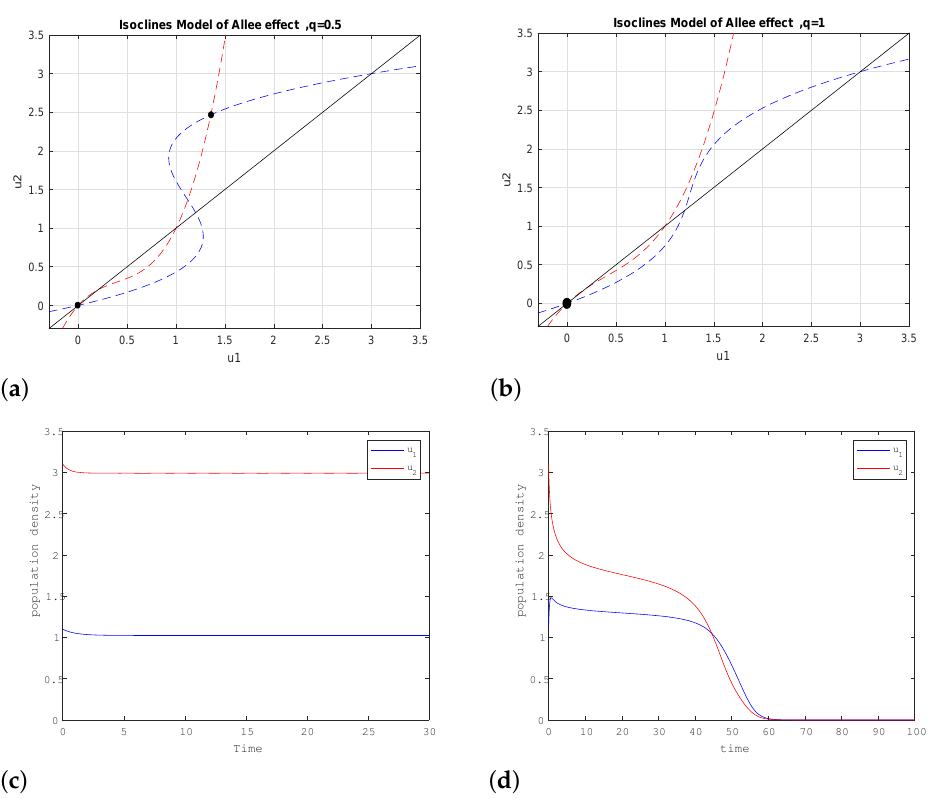
Figure 2. ( a , b ) The phase plane of system (4) shown for different values of the coupling strength: ( a ) q = 0.5 and ( b ) q = 1. The black dot shows the positive steady state, the black line is the bisector line. The positive steady state exists in ( a ) but disappears in ( b ). Other parameters are k 1 = 1, k 2 = 3, α 1,2 = 1, β 1 = 0.2 and β 2 = 1.2. ( c , d ) The temporal dynamics of the system obtained for cases ( a , b ), respectively, for the initial conditions u 1 ( 0 ) = 1.1 and u 2 ( 0 ) =